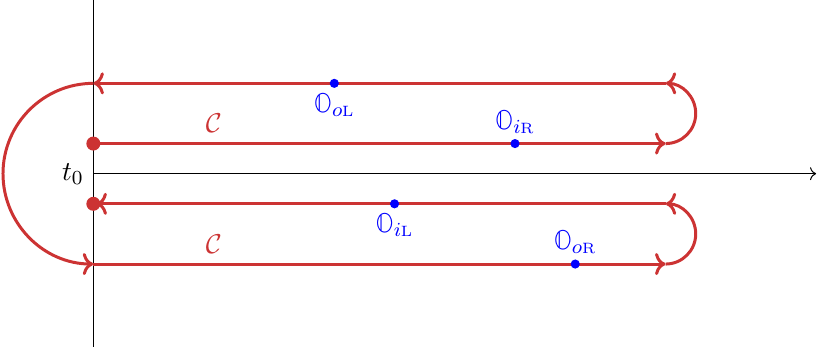
Figure 4 . The 2-OTO contour computing the correlation functions with operators inserted out of the conventional Schwinger-Keldysh time-ordering, cf. eq. (10.1). As usual the initial state is prepared at time t 0 and the latest operator insertion happens at time t . The indicated operator